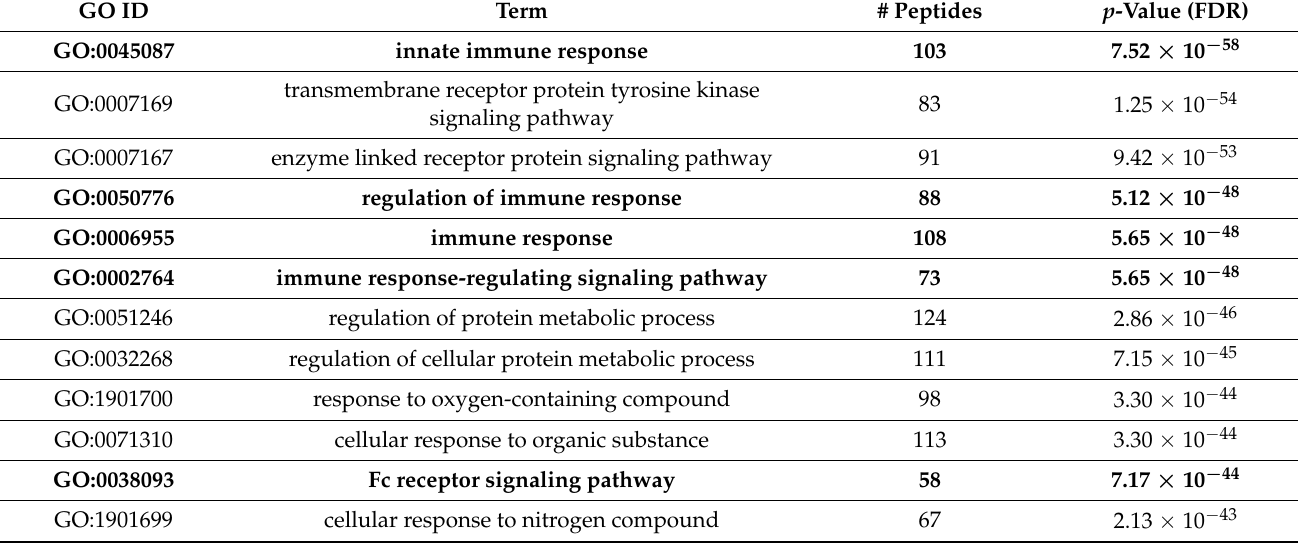
Table 6. The top 12 GO biological processes in sub-iliac lymph nodes collected from fed beef cattle and cull dairy cattle. The statistically significant peptides were generated from the comparison of feedlot and cull dairy cattle sub-iliac lymph nodes using the online STRING database to generate a list of representative GO terms. The top 12 terms are listed. The pathways in bold are those involved in the immune response (total immune peptides: 430).